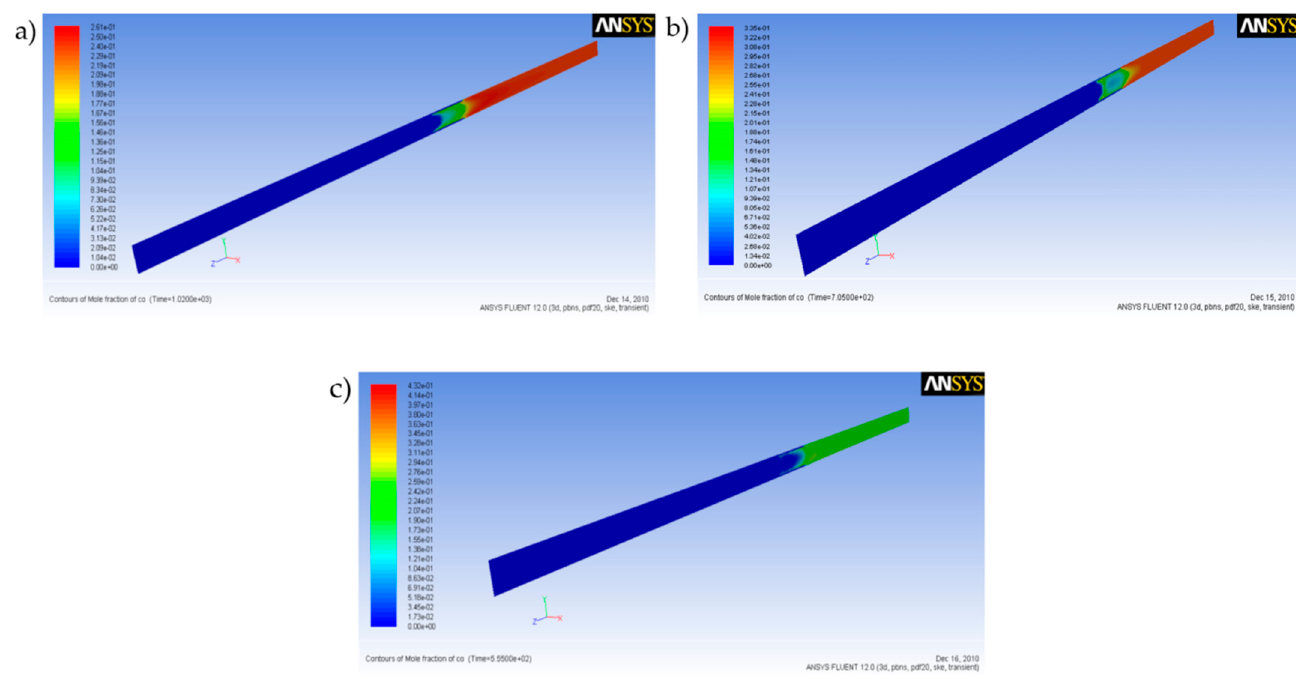
Figure 25. Map of CO variations in the syngas for the numerical simulation: ( a ) coal sample from hard coal mine A in 1040 s, ( b ) coal sample from hard coal mine B in 704 s, ( c ) coal sample from hard coal mine C in 545 s.